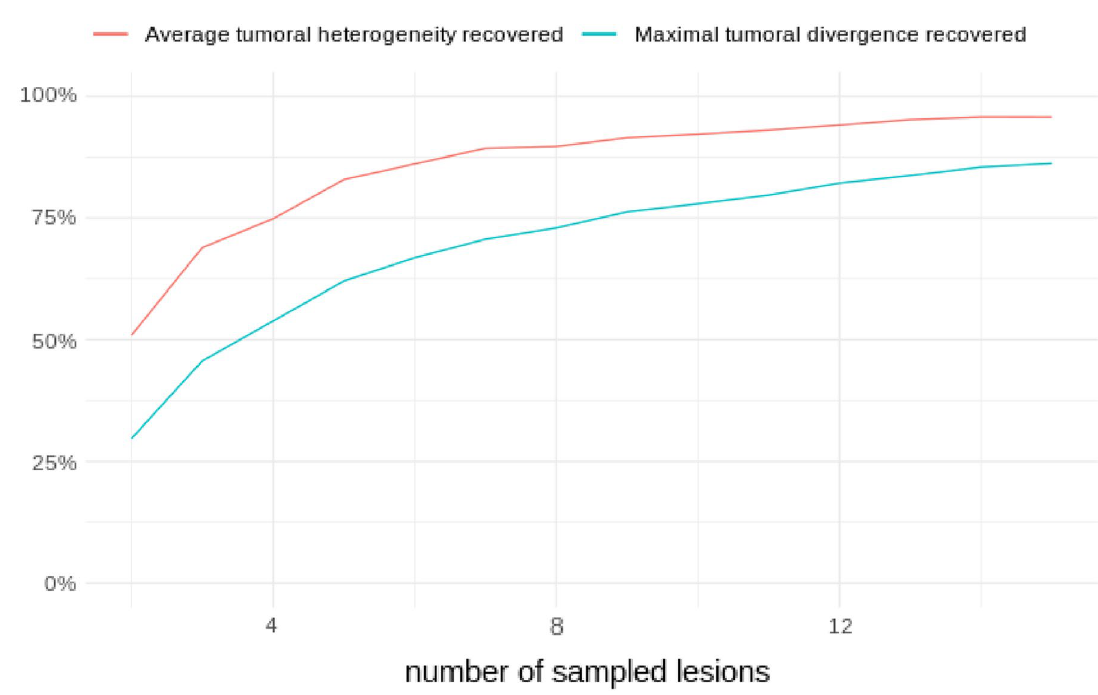
Figure 6. Recovery curves of maximal tumoral divergence and average tumoral heterogeneity for cohort L. Commonly used subsampling strategies select up to 3–4 lesions, failing to correctly capture intra-patient inter- tumor heterogeneity. Even when the delineation effort is scaled up to 15 lesions, none of the two heterogeneity indexes are fully